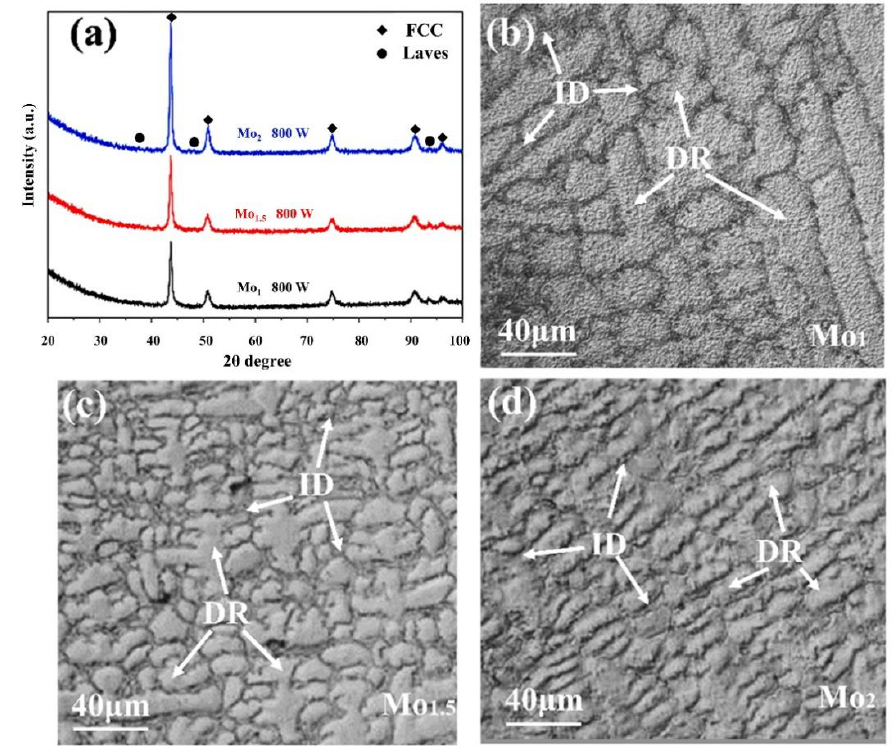
Figure 5. ( a ) XRD patterns of the ((CoCrFeNi) 95 Nb 5 ) 100 − x Mo x ( x = 1, 1.5, 2) HEA coatings, ( b – d ) SEM images of the ((CoCrFeNi) 95 Nb 5 ) 100 − x Mo x ( x = 1, 1.5, 2) HEA coatings. The microstructure of the ((CoCrFeNi) 95 Nb 5 ) 100- x Mo x HEA coatings with laser beam